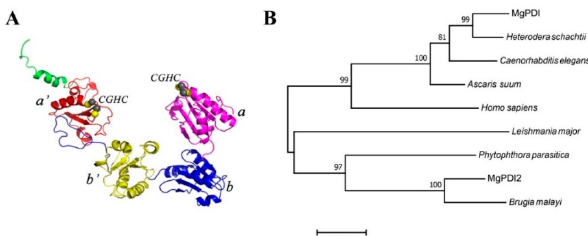
Figure 1. Sequence analysis of MgPDI2. ( A ) The tertiary structure of MgPDI2. ( B ) Molecular phylogenetic analysis of protein disulfide isomerase (PDI) proteins from di ff erent organisms based on PDI-deduced amino acid sequences. The numbers indicated on the nodes are the bootstrap values for each cluster based on 1000